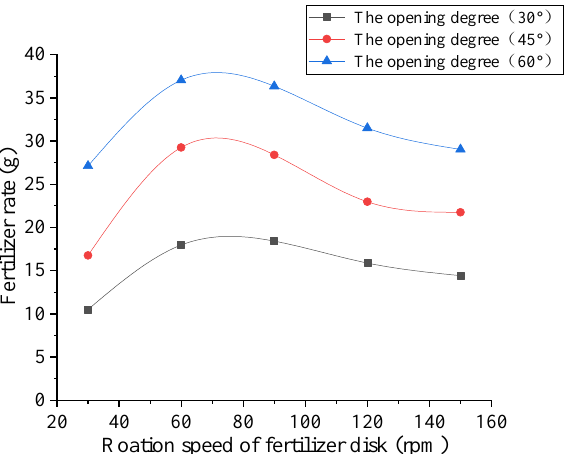
Figure 6. Simulation results of the variation of the amount of fertilizer discharge with the rotation speed under different opening degrees.